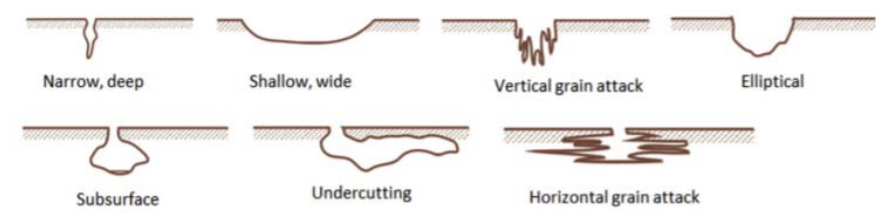
Figure 3: Common pit shapes